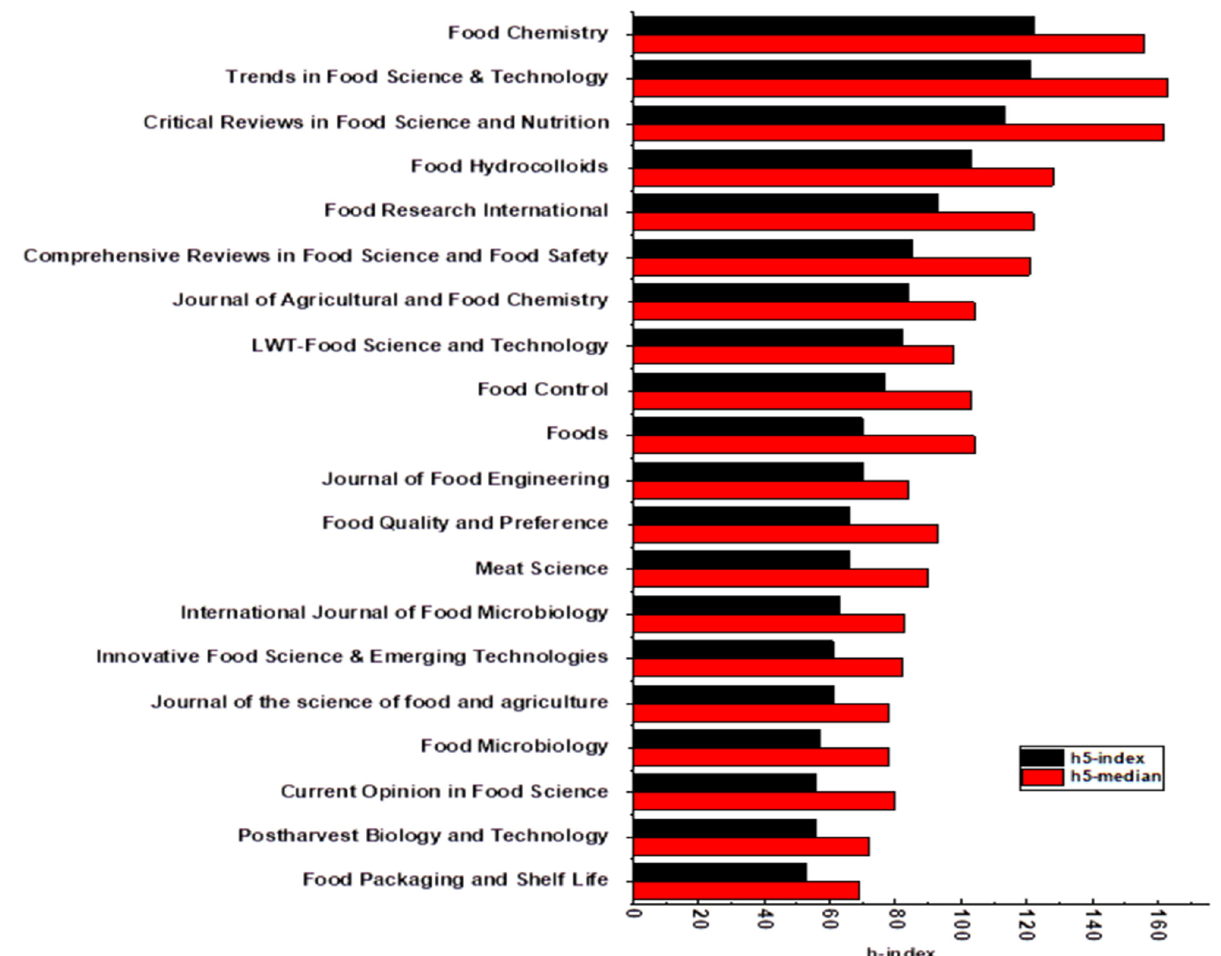
Figure 1. The h 5-index for articles published in the last five complete years (2017–2021) in food science and technology.